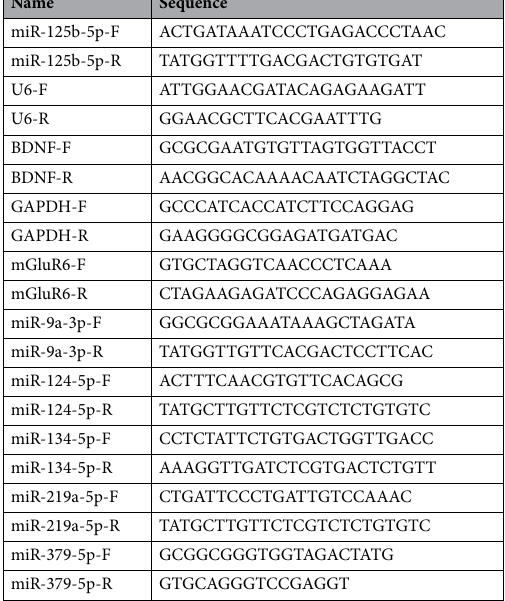
Table 1. Primers for